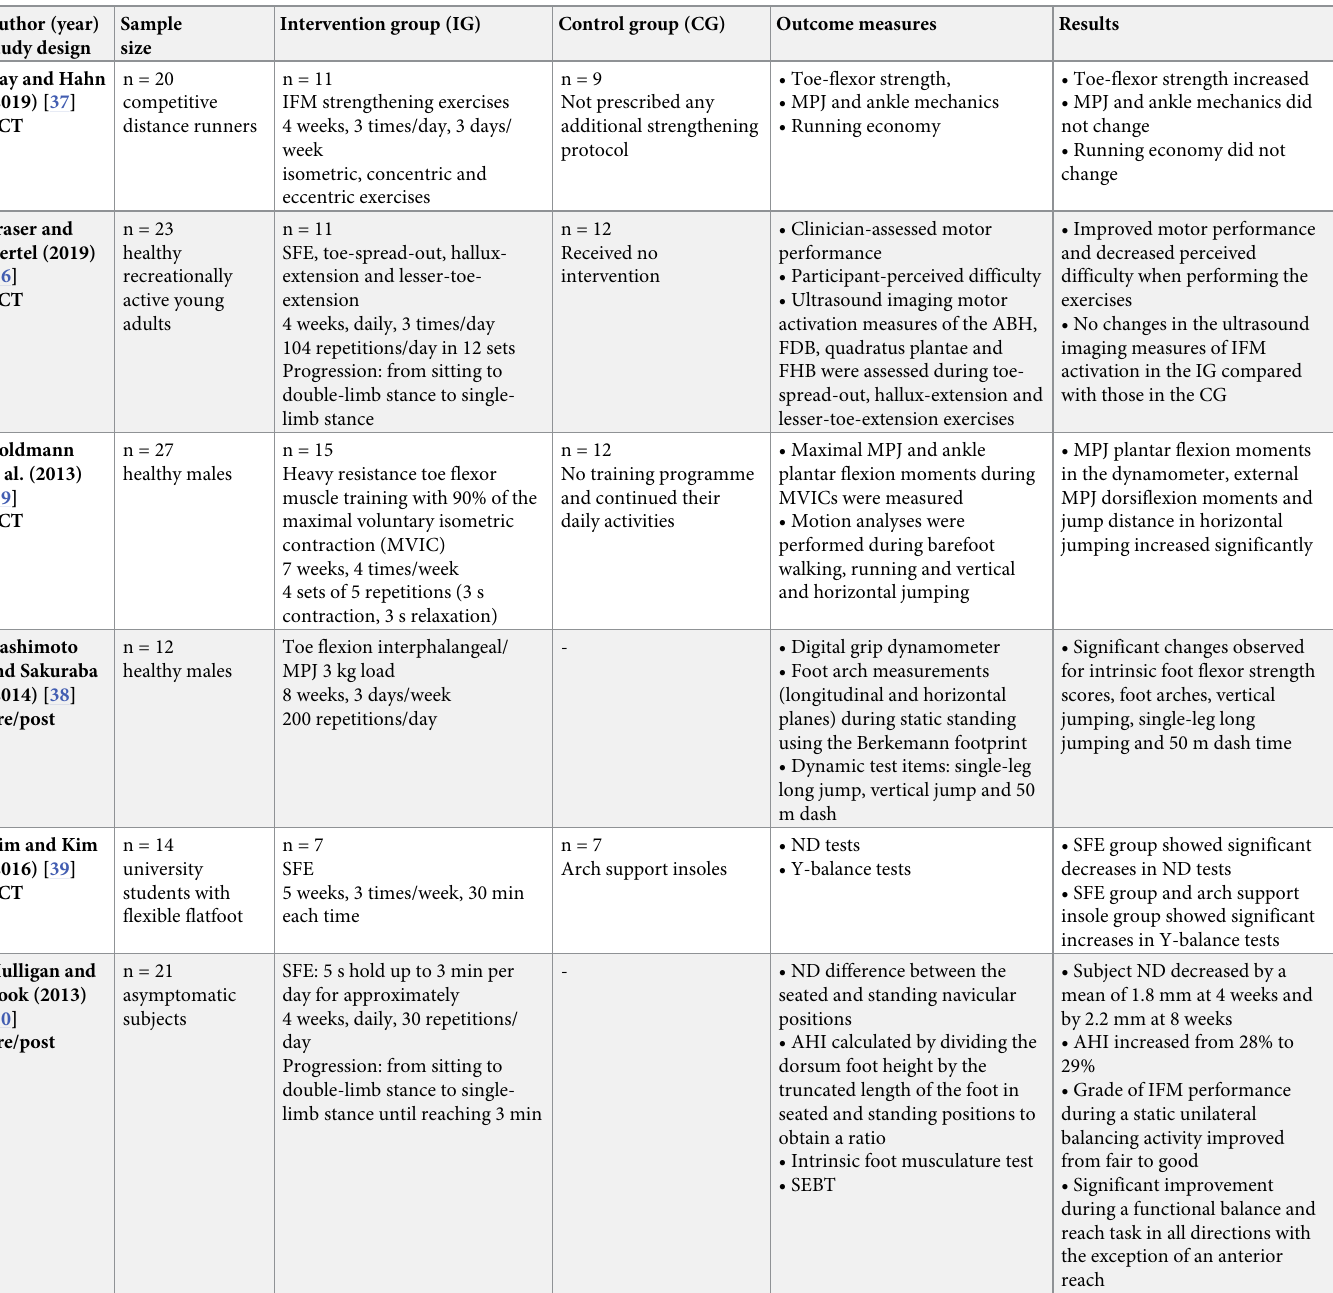
Table 2. Characteristics of the included